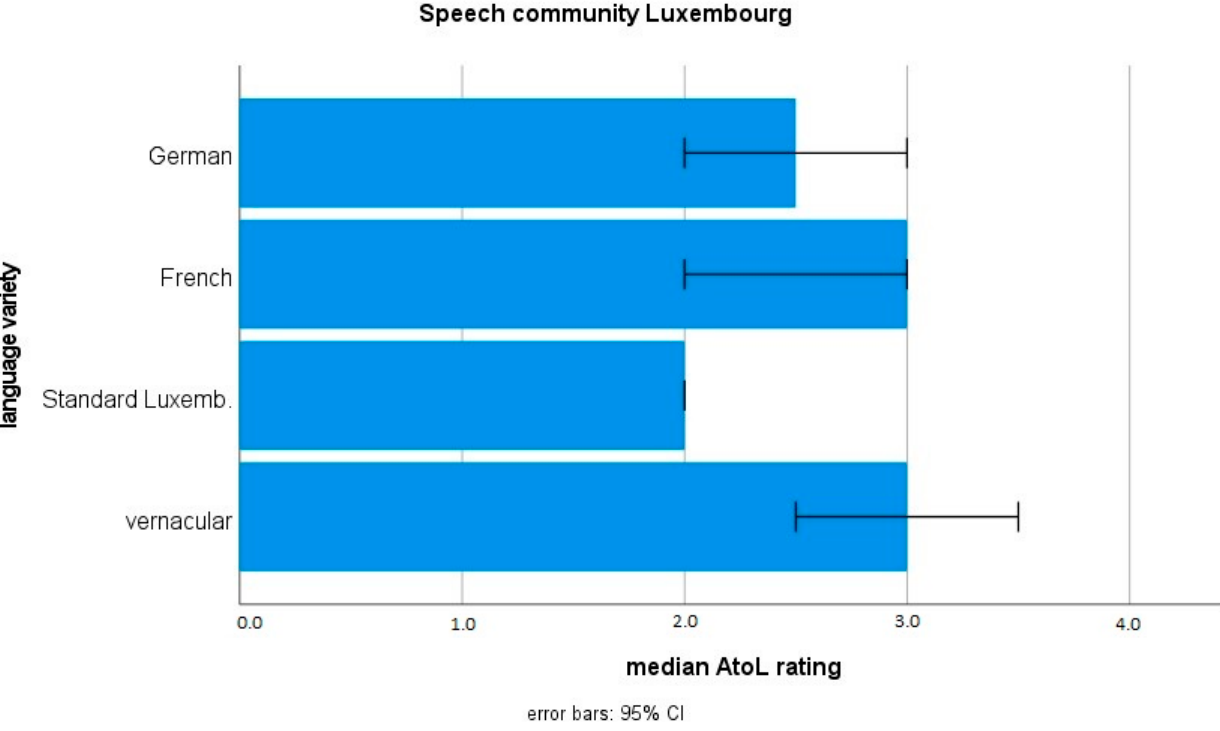
Figure 3. AtoL ratings in Luxembourg: vernacular* (median = 3.00; IQR = 2.00, 3.00, 4.00), standard* (median = 2.00; IQR = 2.00, 2.00, 2.50), French (median = 3.00; IQR = 2.00, 3.00, 3.38), German* (median = 2.50; IQR = 2.00, 2.50, 3.00). * sign. different.